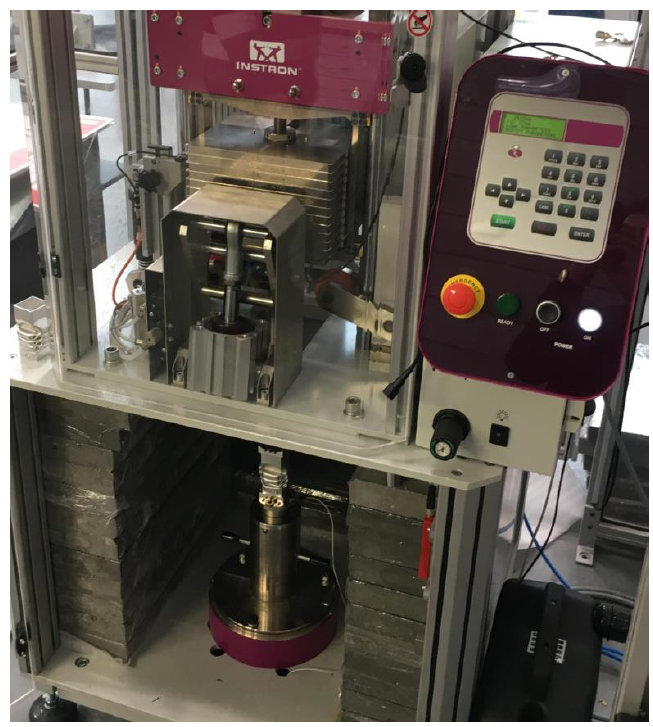
Figure 8. General view of dynamic testing machine Instron Ceast 9450 HES.